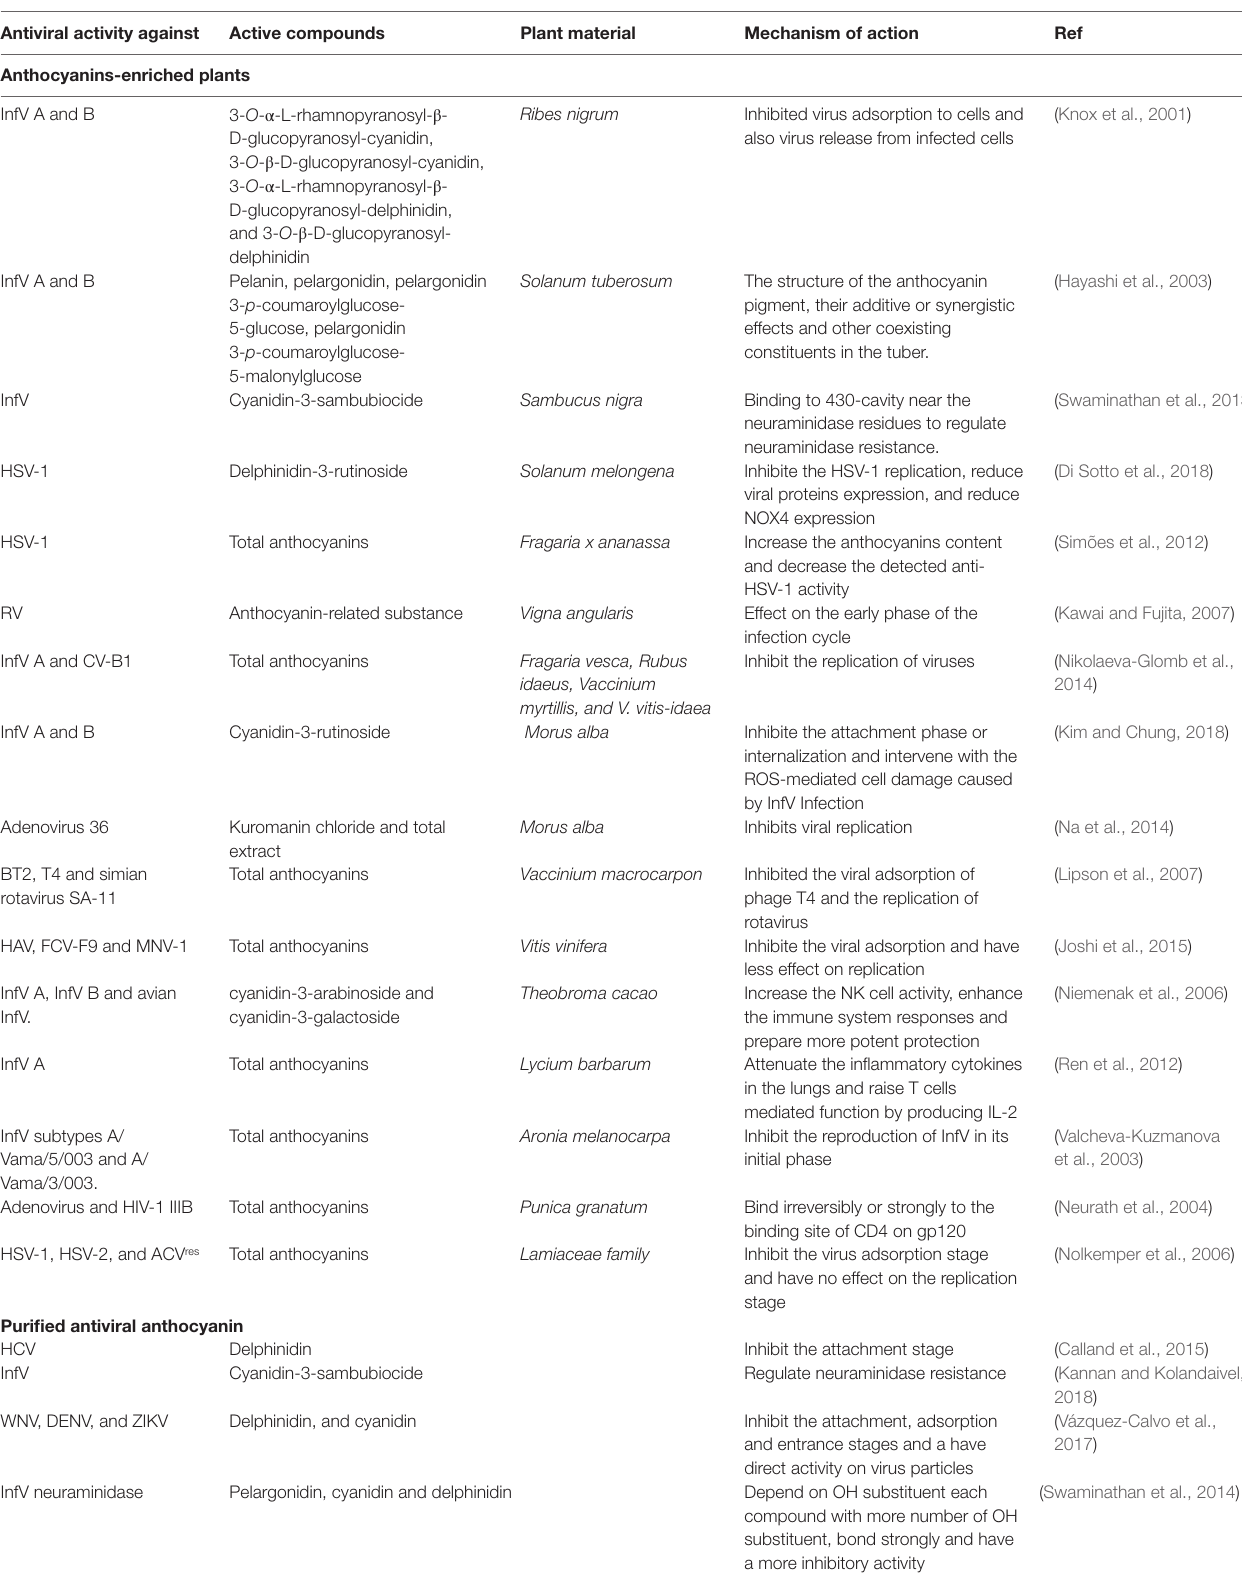
TABLE 2 | The antiviral activity of anthocyanins-enriched plants and purified anthocyanins with their pharmacological activity. Antiviral activity